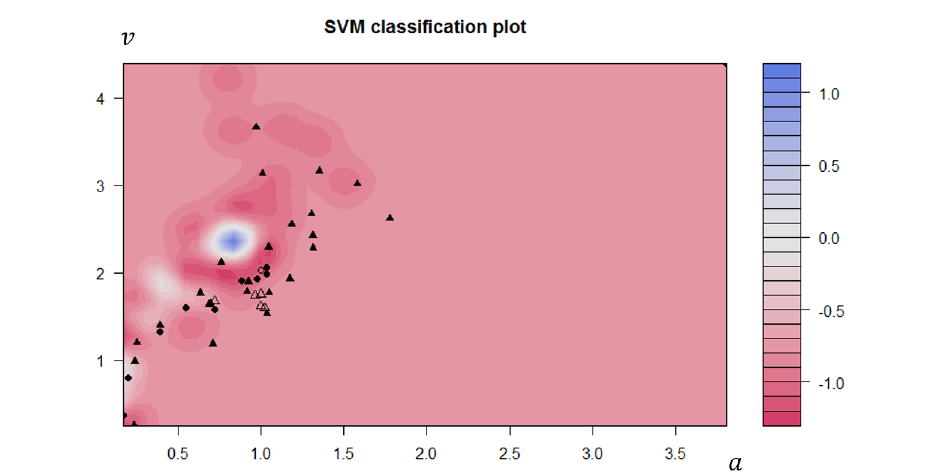
Figure 7. SVM classification, where straightening space specified using Gaussian